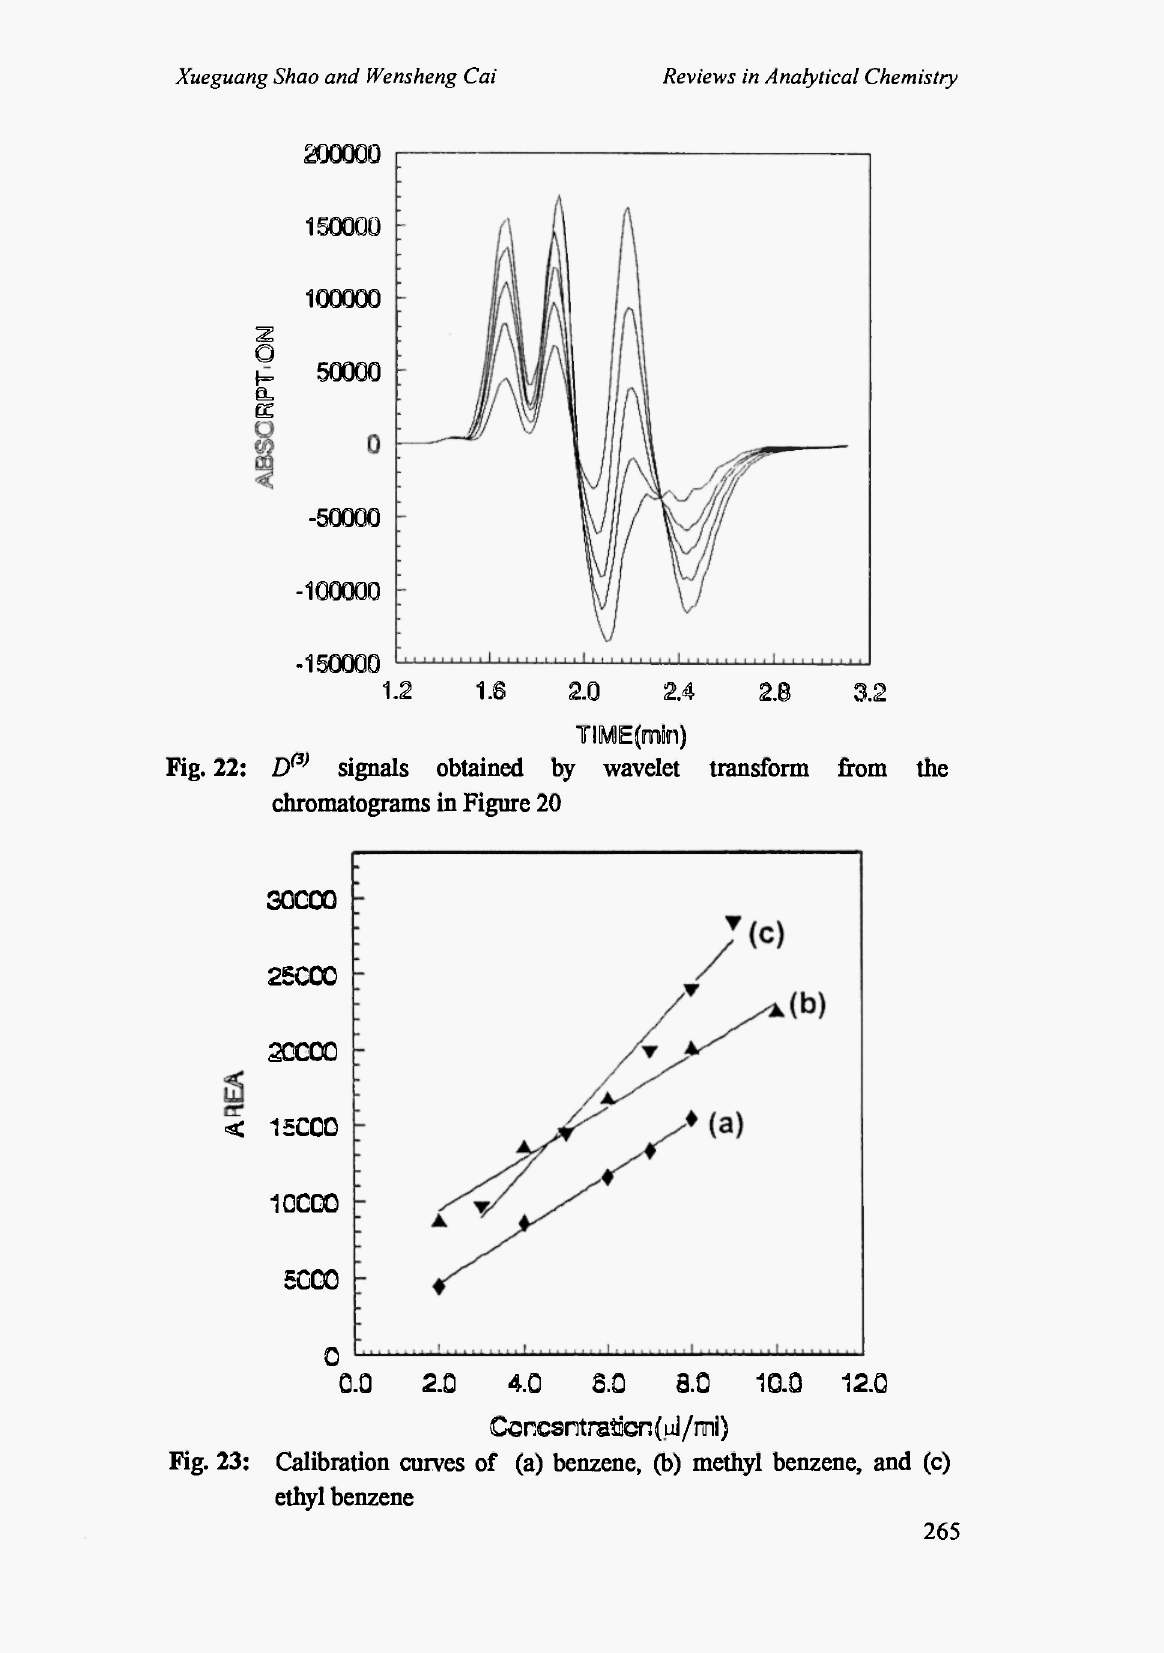
Fig. 23: Calibration curves of (a) benzene, (b) methyl benzene, and (c) ethyl